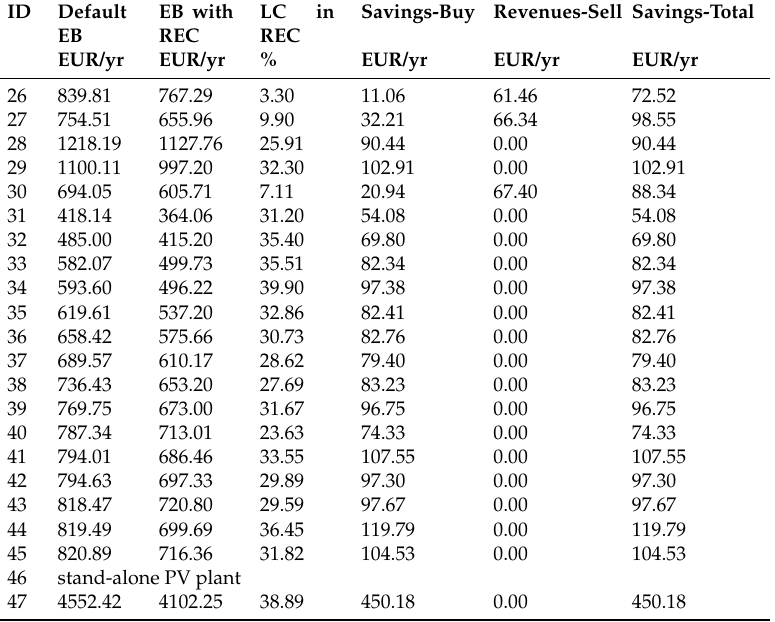
Table 11. REC of residential customers, a stand-alone PV plant and a commercial customer: Results for customers 26–45; the commercial customer is assigned ID 47. Detailed explanation of the individual columns given in Table 5. Note, that revenues due to selling electricity within the community are zero for MAB residents 31–45 despite the availability of an in-house PV system, because the PV system is